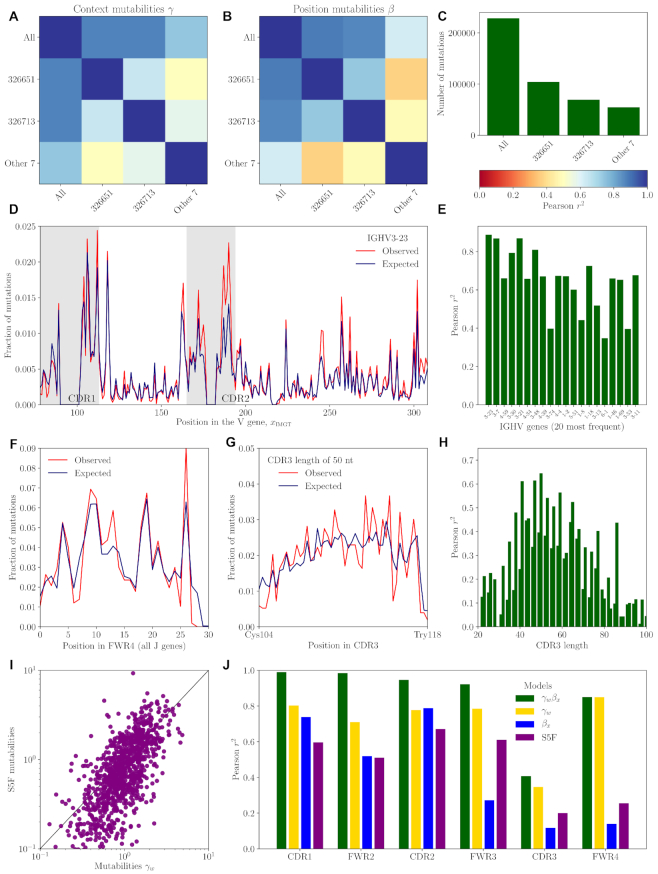
The model explains the data. Observed profiles were measured across the entire dataset used for model inference. See Supplementary Figure S6 for an equivalent figure when data was divided into training and testing sets. Reproducibility of parameters for individual-specific models: context (A) and position (B) mutabilities. (C) Number of mutations used for inference (D) An example mutation profile in the most common V gene. (E) Model performance across V genes. (F) Mutation profile in the FWR4 region. (G) An example mutation profile in the CDR3 region for CDR3 length of 50 nts. (H) Model performance across CDR3 lengths. (I) Comparison with the S5F model. (J) Summary of models performance across sequence regions. We compare the full context- and position-dependent model (γ\documentclass[12pt]{minimal}
\usepackage{amsmath}
\usepackage{wasysym}
\usepackage{amsfonts}
\usepackage{amssymb}
\usepackage{amsbsy}
\usepackage{upgreek}
\usepackage{mathrsfs}
\setlength{\oddsidemargin}{-69pt}
\begin{document}
}{}$w$\end{document}βx) with purely context- (γ\documentclass[12pt]{minimal}
\usepackage{amsmath}
\usepackage{wasysym}
\usepackage{amsfonts}
\usepackage{amssymb}
\usepackage{amsbsy}
\usepackage{upgreek}
\usepackage{mathrsfs}
\setlength{\oddsidemargin}{-69pt}
\begin{document}
}{}$w$\end{document}) and position- (βx) dependent models as well as with the S5F default model.